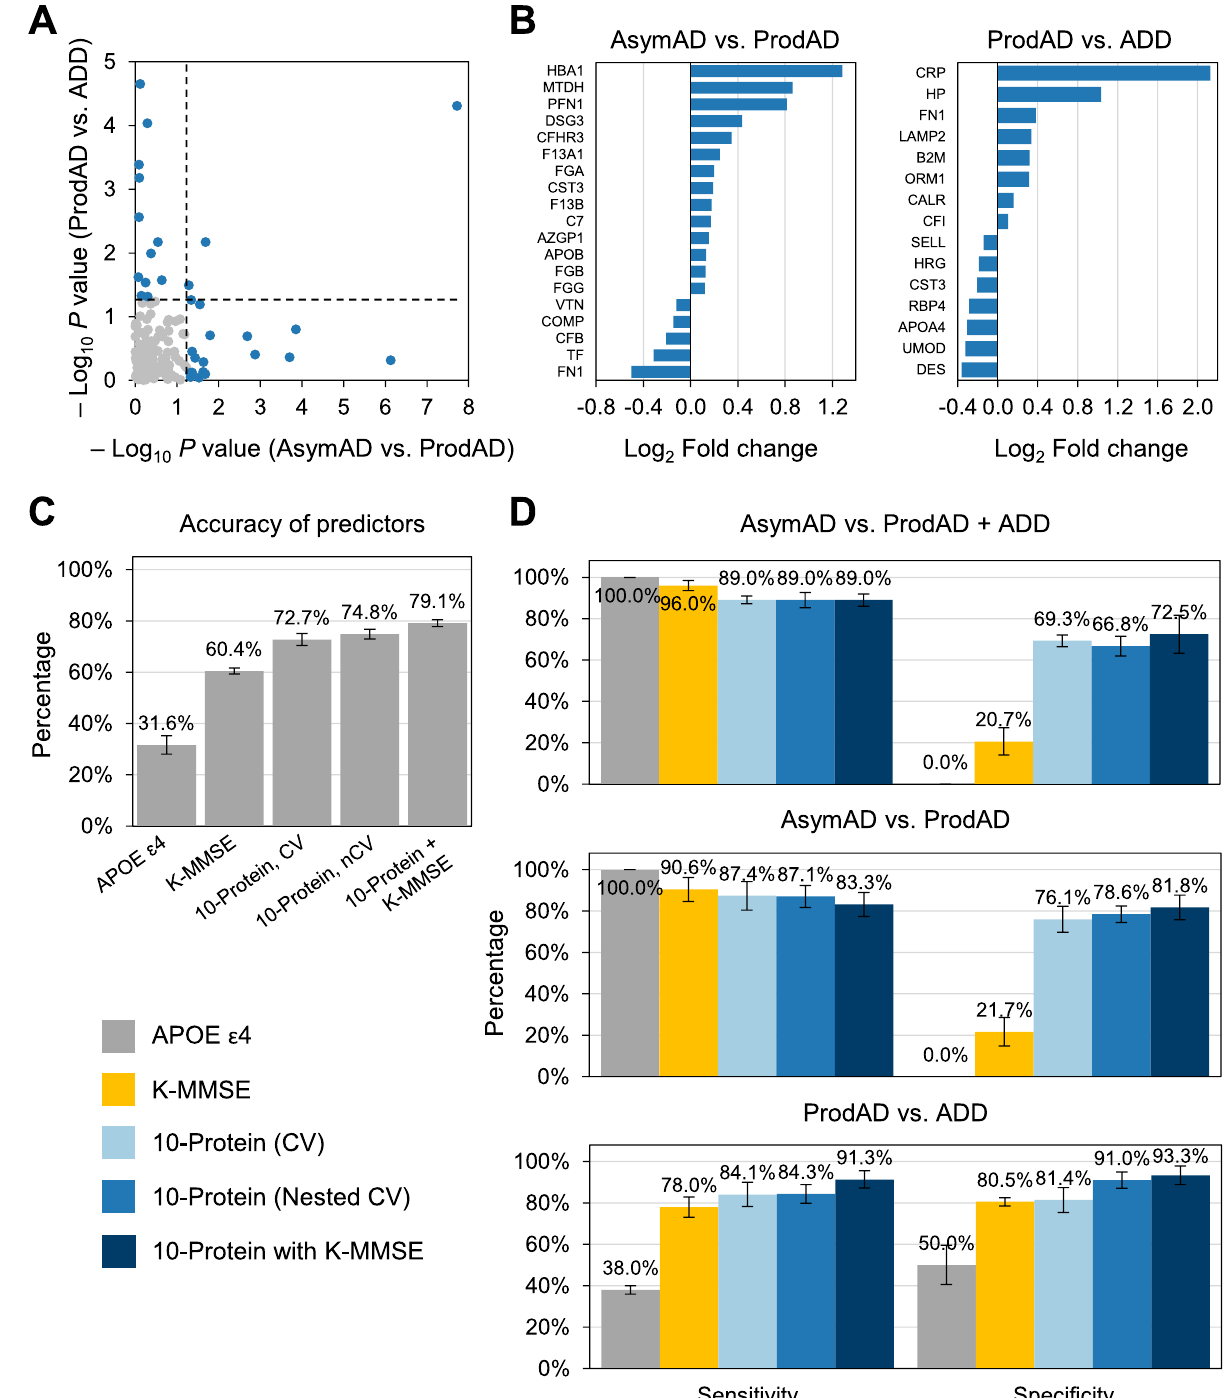
Figure 4. Construction of model for classifying AsymAD, ProdAD, and ADD. ( a ) Scatterplot of P values by student’s t test between “AsymAD” versus “ProdAD” groups and “ProdAD” versus “ADD” groups. Proteins with P values lower than 0.05 are marked as blue dots. ( b ) Fold-change of DEPs in “AsymAD” versus “ProdAD” groups and “ProdAD” versus “ADD” groups. ( c ) Accuracy of APOE ɛ 4 carriers, K-MMSE, 10 proteins performed with nested crossvadation, 10 proteins performed with fivefold crossvalidation, and 10-protein with K-MMSE models. ( d ) Bar plots for sensitivity and specificity of APOE ɛ 4 carriers, K-MMSE, and final model (10-protein with K-MMSE) in model prediction between “AsymAD” versus “ProdAD” plus “ADD” group, “AsymAD” versus “ProdAD” group, and “ProdAD” versus “ADD” group. Error bars represent 95% confidence